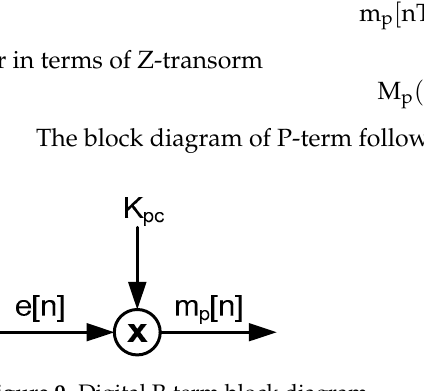
Figure 9. Digital P-term block diagram.